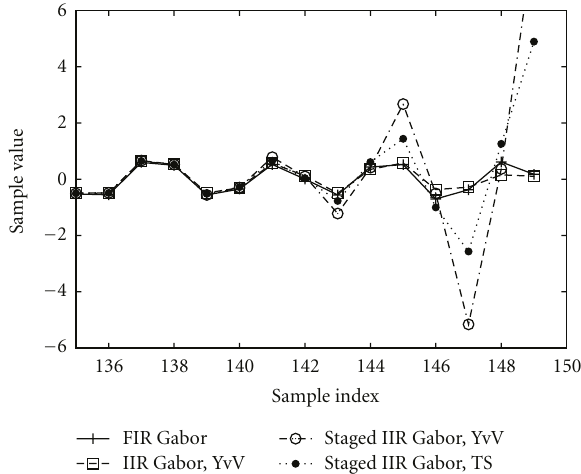
Figure 2: Example of errors after a direct (square marks) and staged (circle marks) Gabor filtering on sample input data: n = 149, Sigma = 3, period = 4px, input extended constantly with the border value. For the staged cases, which is always a modulation, Gaussian filtering, and demodulation, we show that any forward-backward transition for direct Gaussian filtering (discussed in Section 2) shall not be used, despite that this transition may be correct for regular Gaussian filtering. The results on the forward-backward transition are compared to the FIR implementation with constantly extended border as well. The FIR serves as a ground-truth result. The error spans 7 data positions. Only real parts of the complex filtering results are shown